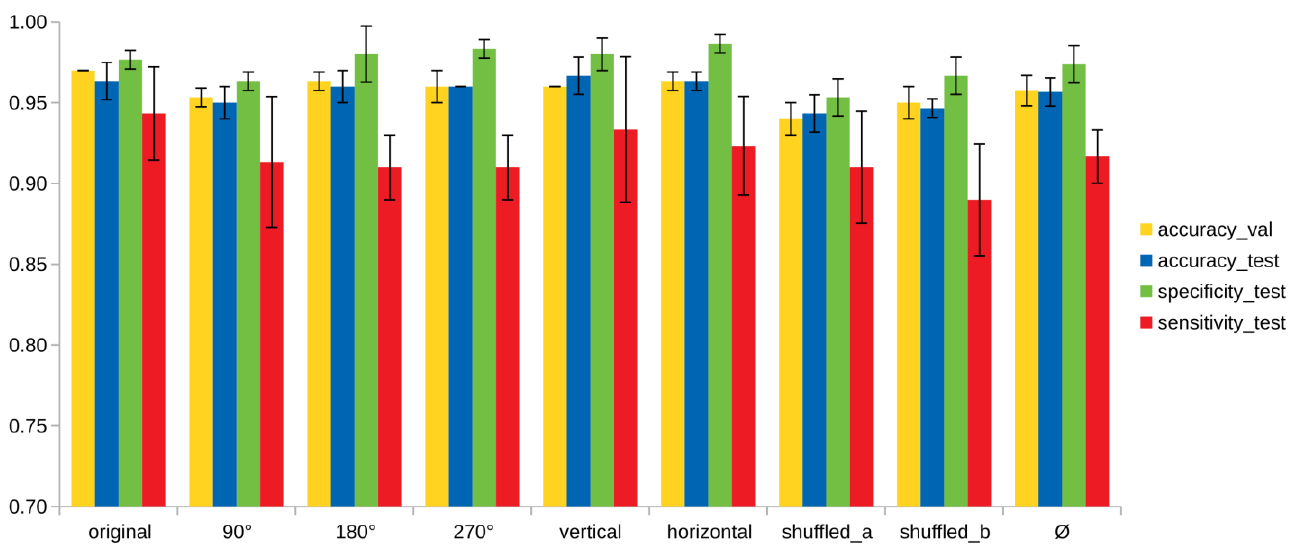
Figure 4. Bar chart of accuracy, specificity, and sensitivity values for the validation and test set. Results are presented for genus level data. For all datasets (original, 90 ◦ , 180 ◦ , 270 ◦ , vertical, horizontal, shuffled_a, and shuffled_b; details in Table 2) the accuracy for the validation and test set, and for the latter the associated ‘ healthy ’ and ‘ T2D ’ classes, are shown.